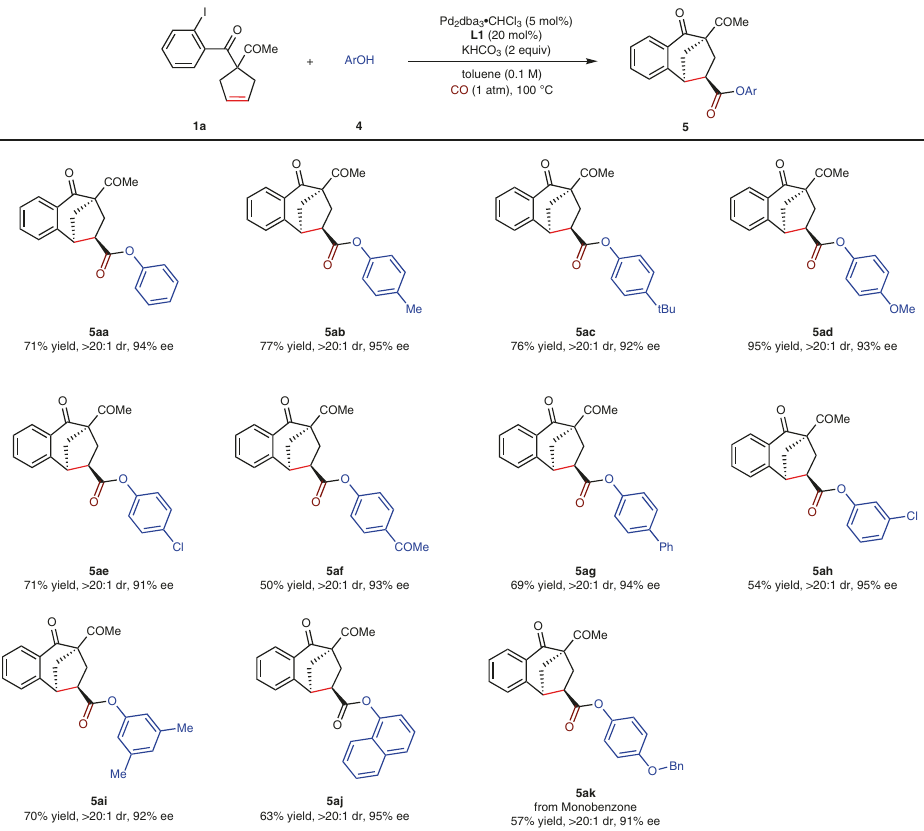
Fig. 3 Substrate scope of phenols. Reaction conditions: 1a (0.1 mmol), 4 (0.25 mmol), Pd 2 dba 3 • CHCl 3 (5 mol%), L1 (20 mol%), KHCO 3 (0.2 mmol) in toluene (1 mL), 100 °C, 36 h, under CO (1 atm). Yields of isolated products are given. The dr values were determined by 1 H NMR analysis. The ee values were determined by HPLC analysis on a chiral stationary